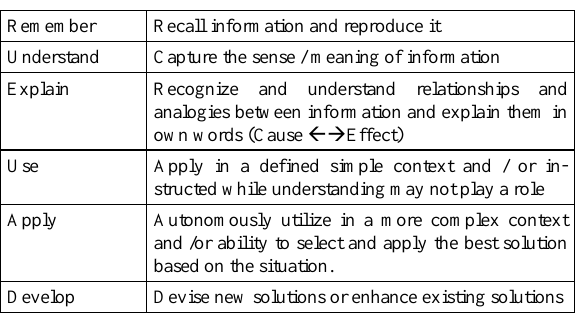
Figure 2. EVELIN classification system to describe technical compe- tencies TABLE I. T HE EVELIN CLASSIFICATION SYSTEM FOR TECHNICAL KNOW HOW [15] [16] - O